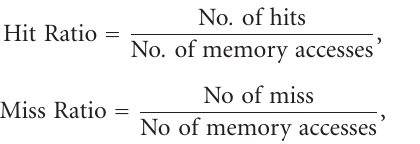
Figure 9: Hit ratio of replacement policy comparison—merge